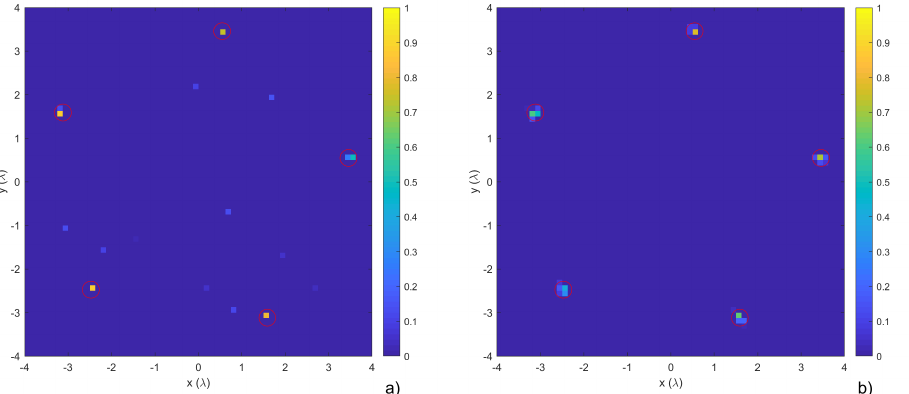
Figure 4. Comparison of the sparse source reconstruction with the two algorithms; the red circles provide the position of the true sparse sources. The subplot ( a ) “standard” algorithm; subplot ( b ): “smooth” algorithm.